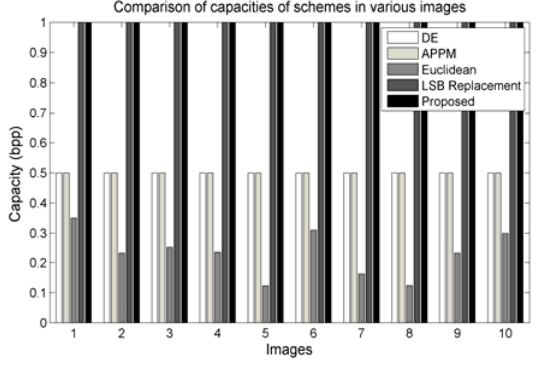
Figure 7. Comparison of embedding capacities among the schemes.